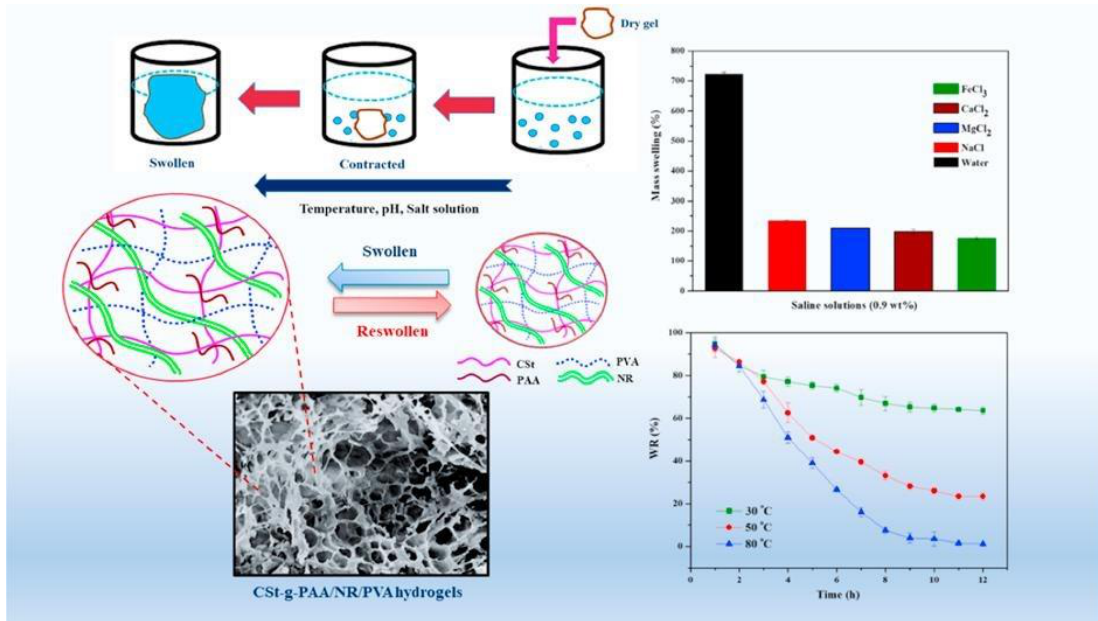
Figure 16. Swelling–reswelling at different pH levels, in salt solutions, morphology, and water uptake of hydrogels [162] .